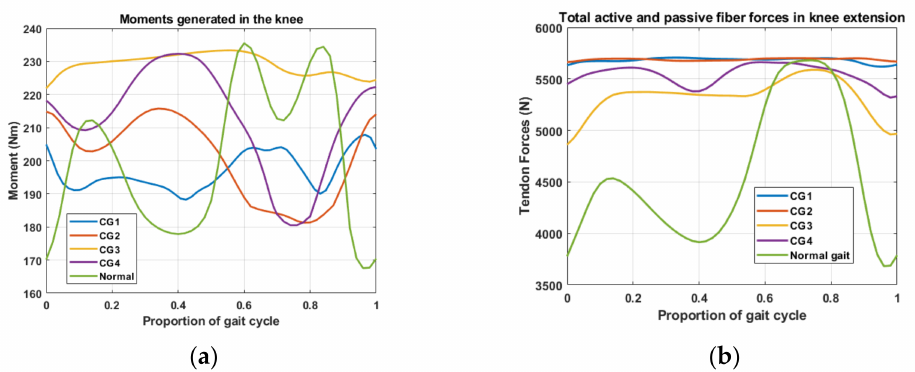
Figure 8. Graphs of ( a ) the moments generated in the knee throughout the gait cycle; ( b ) total active and passive fiber forces generated in the knee extensors.